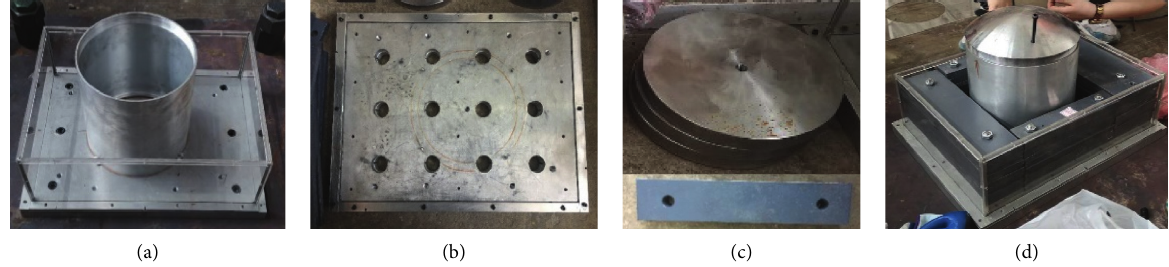
Figure 6: Superstructure-raft model. (a) Superstructure container. (b) Raft. (c) Mass blocks. (d) Integrated superstructure-raft structure.